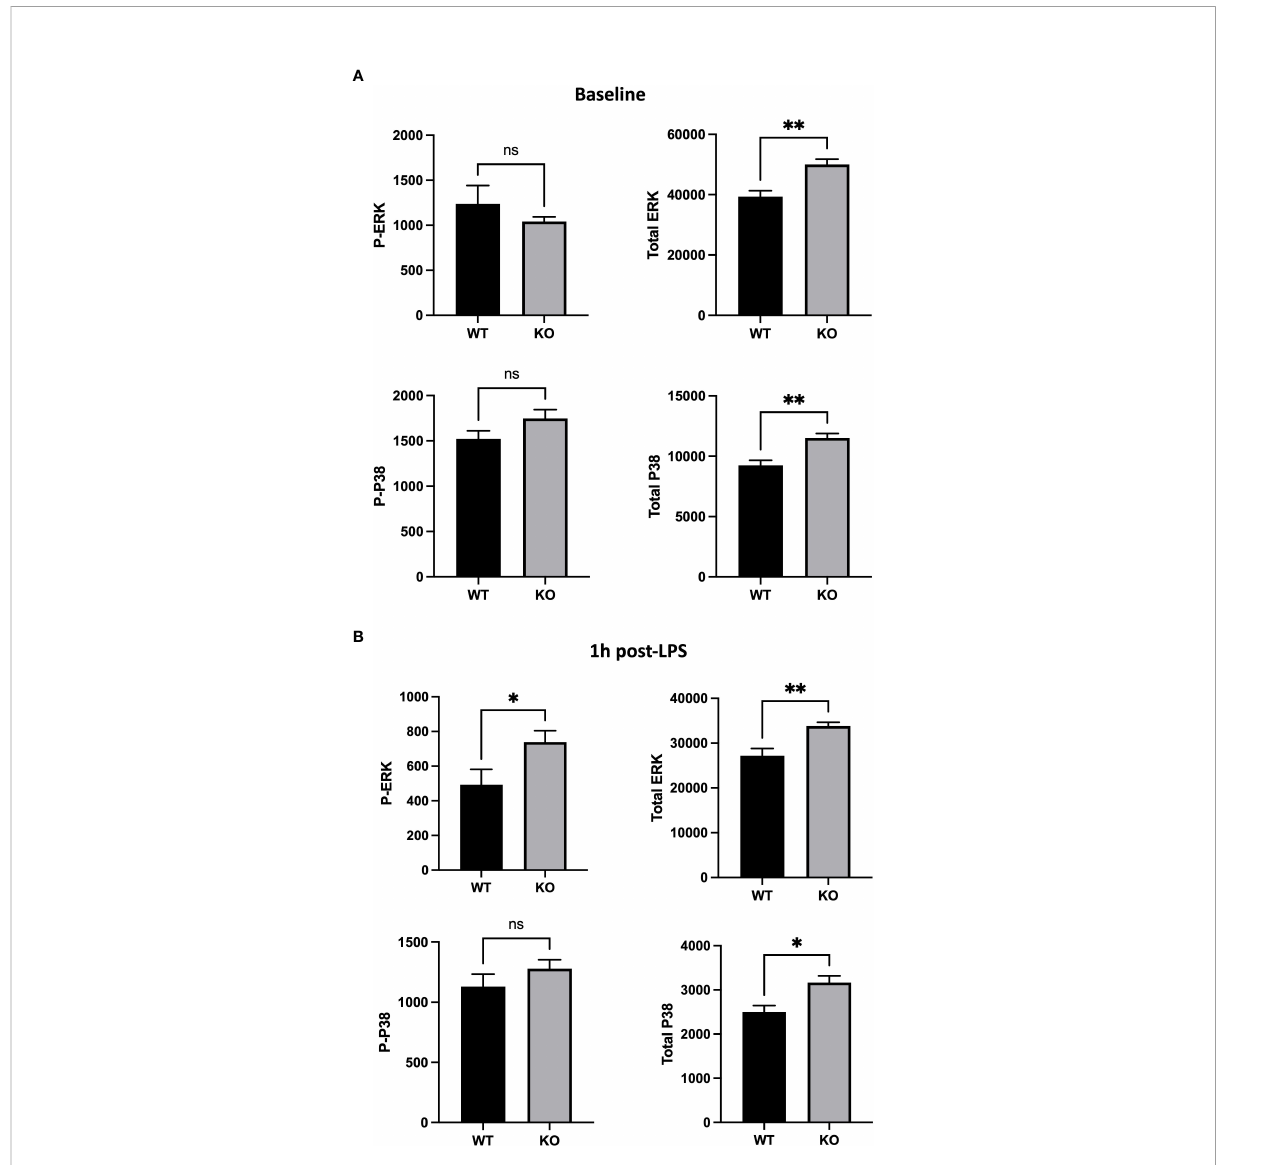
FIGURE 6 Alveolar macrophages (AMs) of CD200 KO rats have an higher expression of in fl ammatory MAP kinases. AMs of WT and KO rats were harvested at (A) baseline and (B) 1h post-LPS exposure. Expression of MAP kinases, ERK and P38, was assessed by fl ow cytometric analysis of delta mean fl uorescence intensity. (A) At baseline, AMs of KO rats had increased levels of total ERK and P38, but similar levels of phospho (P-) ERK and P38. (B) 1h post-LPS, P-ERK and total ERK was increased in AMs of KO rats, as well as total P38. Data are from individual rats, with n = 6-8 per group of two independent experiments. Statistical signi fi cance was determined using Mann-Whitney T-Test; ns: not signi fi cant, *P < 0.05; **P<